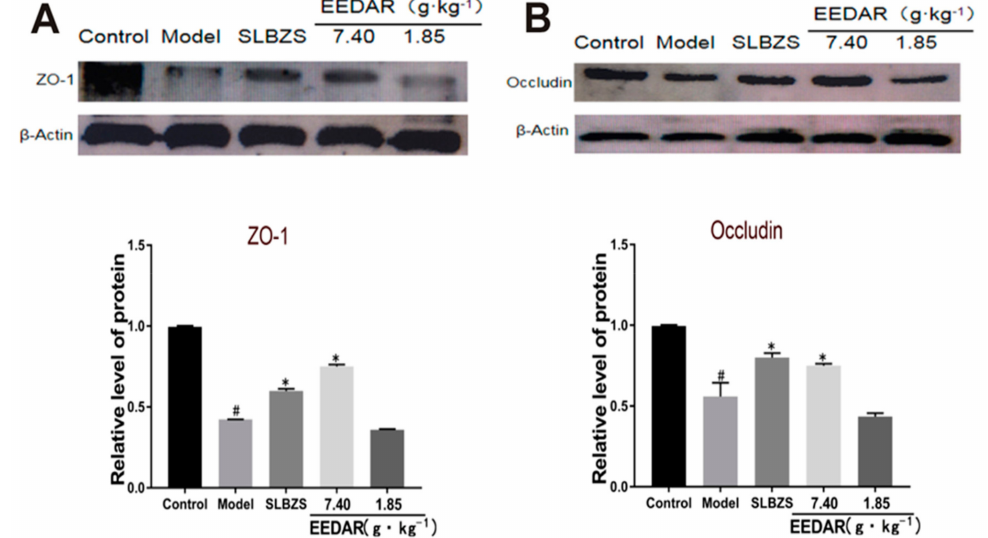
Figure 5. E ff ect of EEDAR on TJ protein expression in spleen-deficiency diarrhea rats ( n = 3). ZO-1 ( A ) and Occludin ( B ) protein expression levels in colon tissue were measured by Western blot analysis. Expression bands were quantified, and values normalized to β -actin levels. Values represent means ± SEM. # p < 0.05 vs. Control; * p < 0.05 vs.